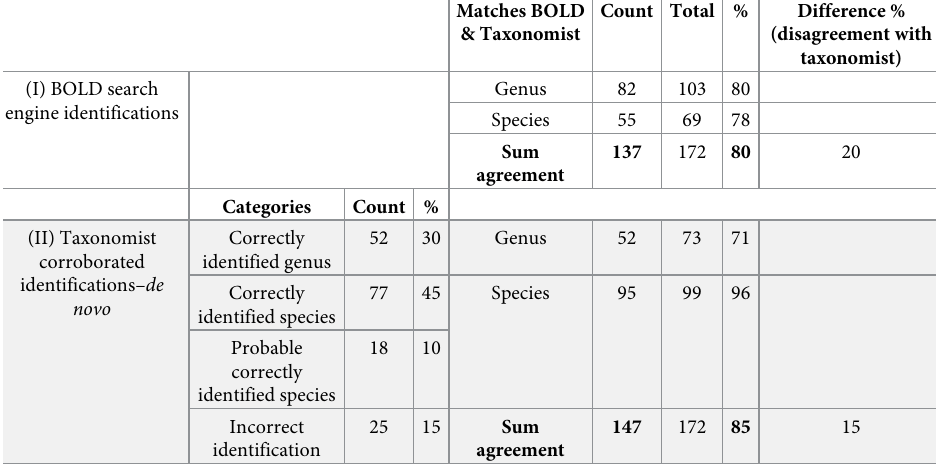
Table 3. Summary of matches between the taxonomist and BOLD identifications for the subfamily of dung bee- tles Scarabaeinae. The first section (I) corresponds to the initial matches performed in agreement with the taxonomist after the search engine in BOLD at 80%. The second section (II) in grey includes the categories used by the taxonomist to reevaluate the identifications provided by BOLD in (I) and the final matches in agreement. Matches BOLD Count Total % Difference % & Taxonomist (disagreement with